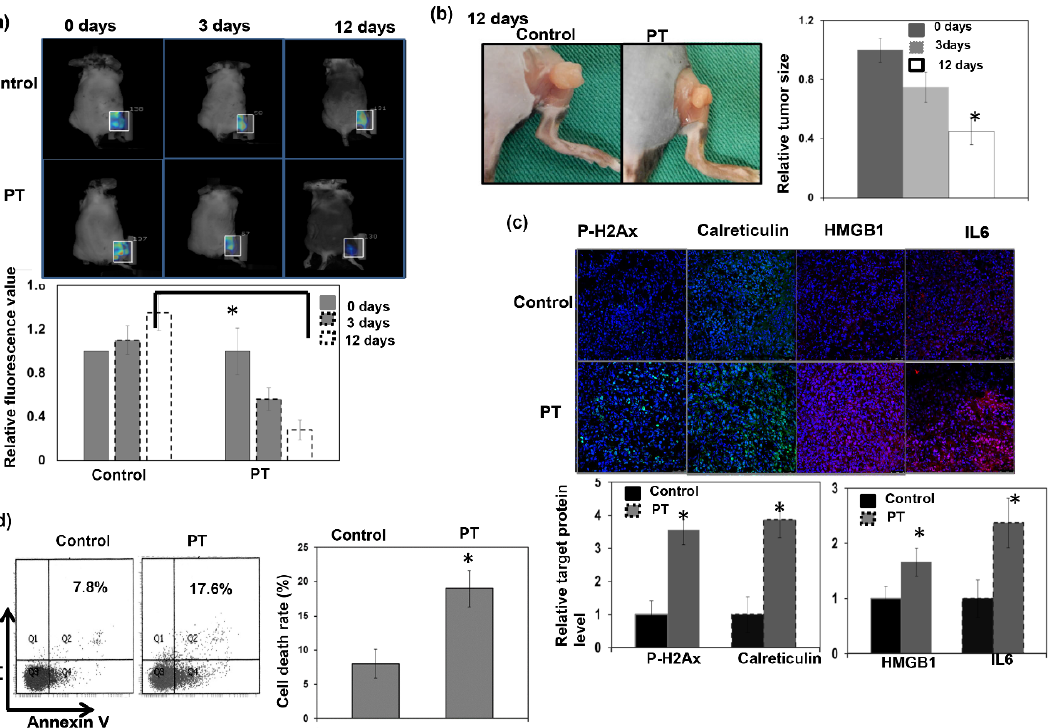
Figure 3. Response to PT treatment in immunocompetent mice. Representative images and quantita- tive data were determined via FMT analysis of glucose uptake at 0, 3, or 12 days with or without PT irradiation ( a ). The y axis represents the ratio normalized by the value of tumor at 0 day with sham irradiation. Representative images and quantitative data of tumor pictures ( b ) from mice bearing s.c. tumors 12 days after 12 Gy (RBE) PT or sham irradiation are shown. The y axis represents the relative fold change in tumor size at the indicated time after PT. DNA damage by IF ( c ) and cell death by FACS ( d ) were evaluated at 3 days after PT. The y axis is the relative fold change in target protein expressions and the cell death rate at 3 days after PT. Data are presented as means ± standard errors of the mean. * p < 0.05.